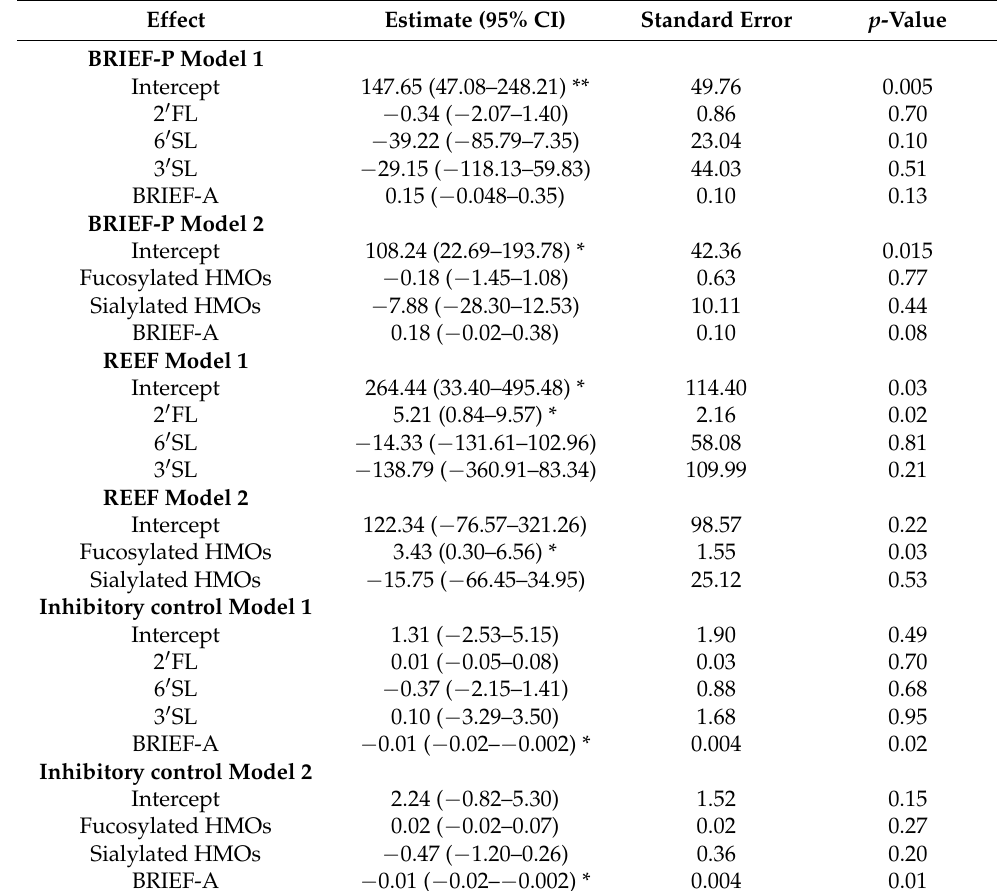
Table 7. Associations between HMOs and executive functions (BRIEF-P and REEF) and inhibitory control (exclusively breastfed